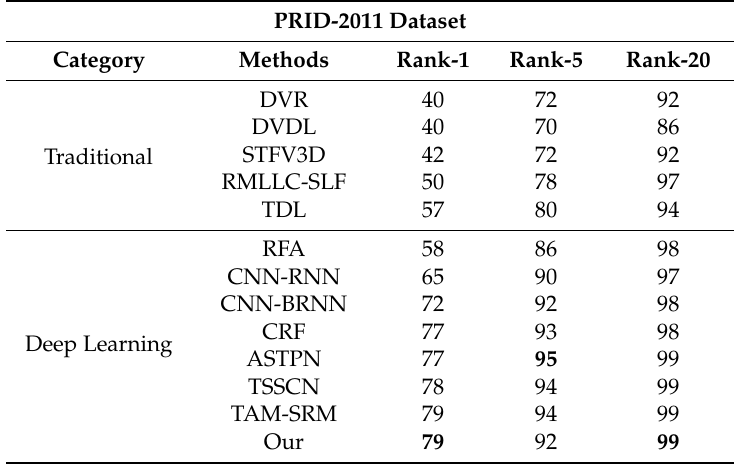
Table 3. Comparison experiment with two types of state-of-the-art algorithms for the PRID-2011 dataset in terms of CMC